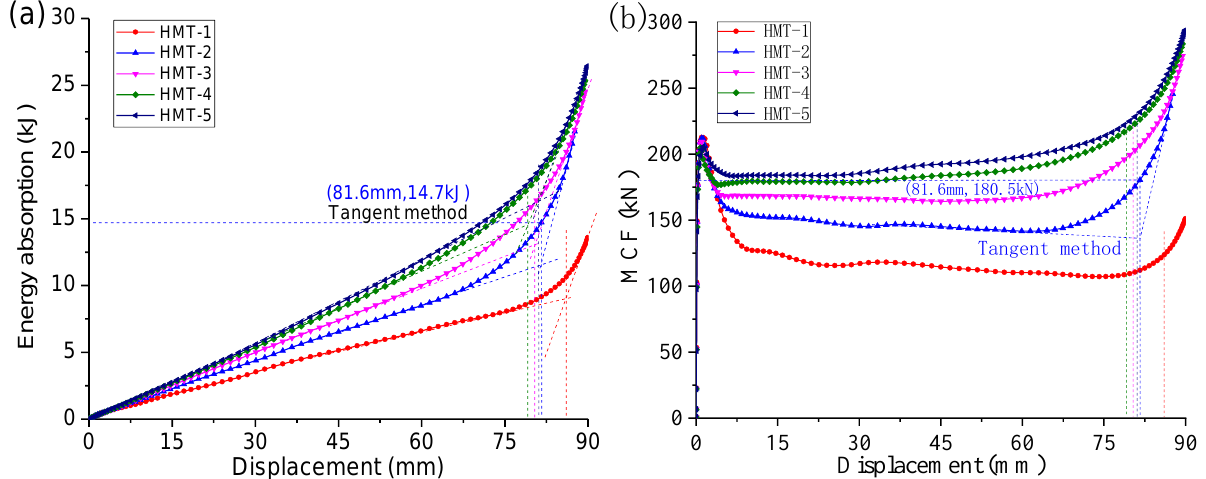
Figure 15. FEM ( a ) energy absorption and ( b ) MCF of compressed HMTs. Table 7. FEM-simulated crushing data of HMTs based on tangent